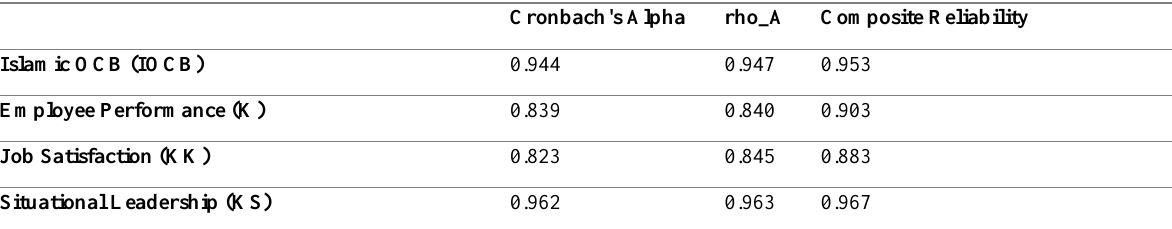
Table 2: Composite Reliability and Cronbach’s Alpha